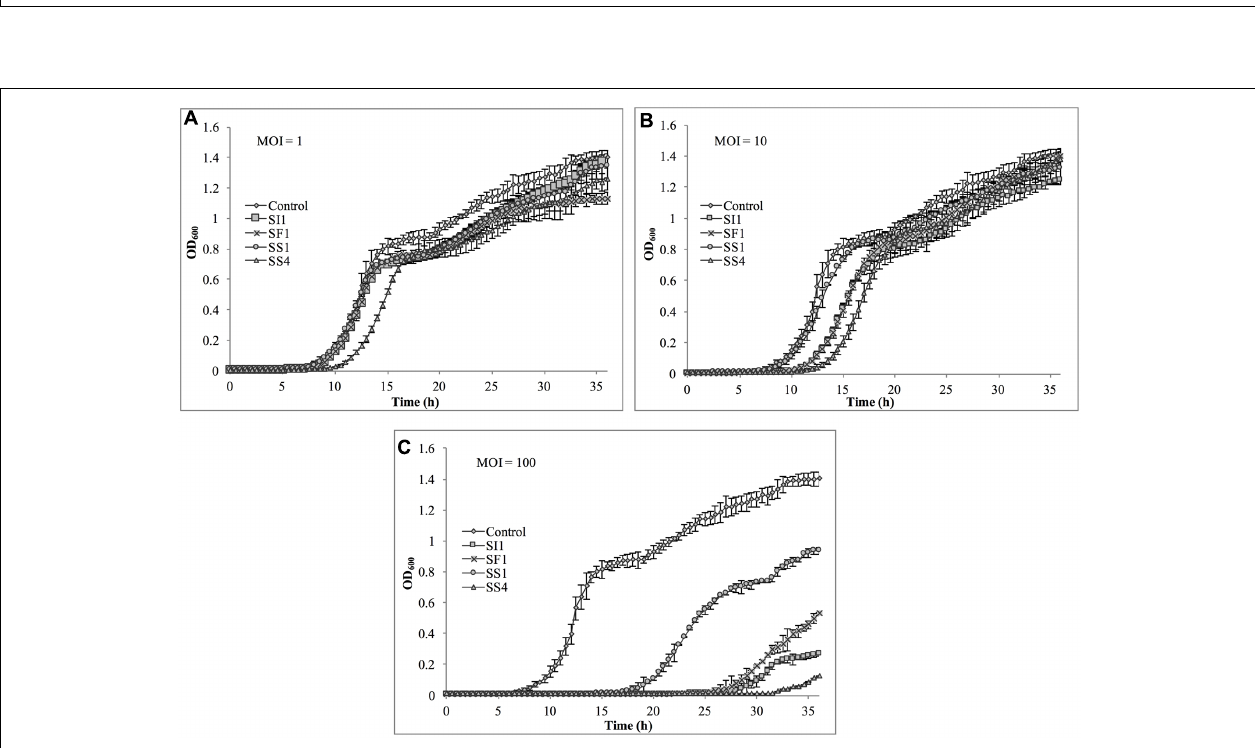
FIGURE 7 | In vitro analysis of S. Agona inhibition by phages SI1, SS4, SF1, and SS1 at (A) MOI = 1, (B) MOI = 10, and (C) MOI = 100. Data shown are the mean of three replicates ± SD.